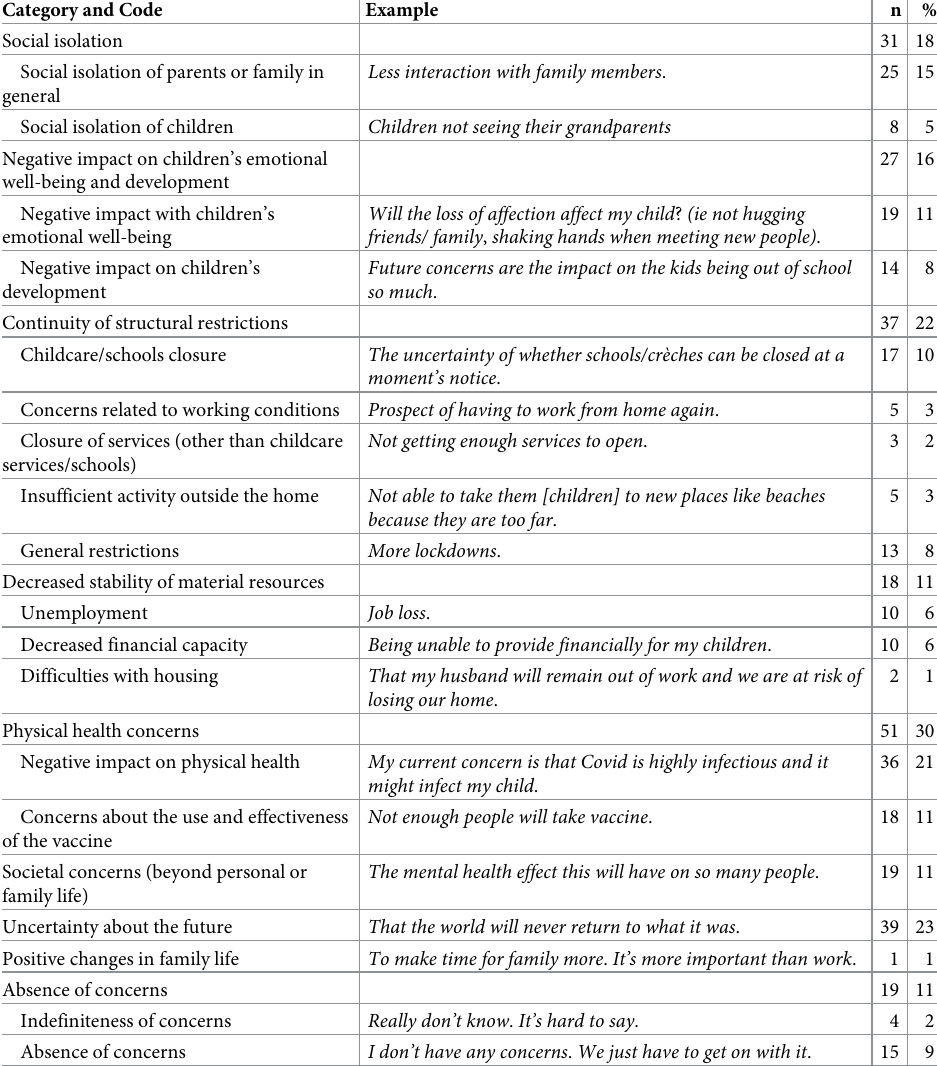
Table 3. Codes and categories within concerns related to the Covid-19